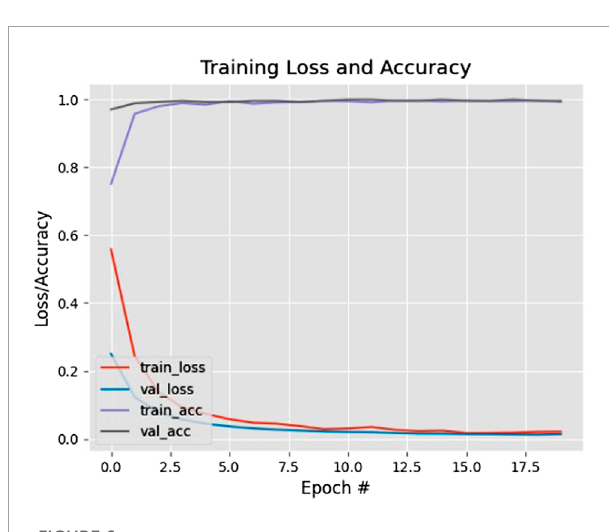
FIGURE 6 Accuracy/Loss plot of Face mask